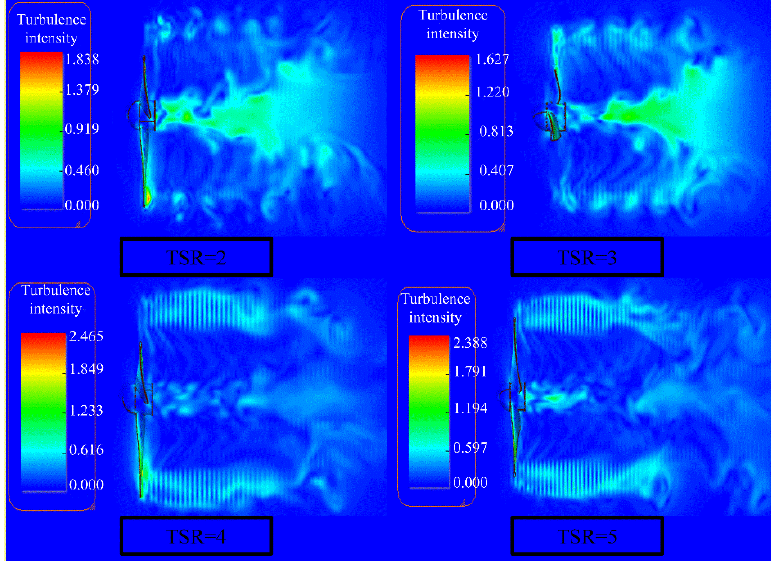
Figure 11. Turbulence intensity distributions in different TSR.